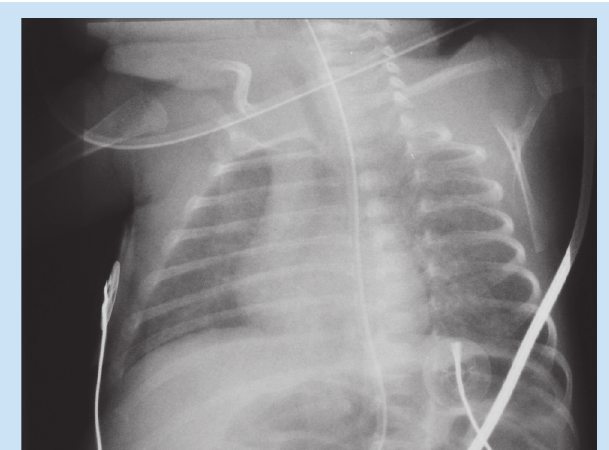
Fig. 15. Previous surgery. In addition to the ETT and NGT there is a clip for repair of the patent ductus arteriosus. There is an abnormal rib noted on the left consistent with this previous surgery. The asymmetrical airspace disease is in keeping with superadded infection.